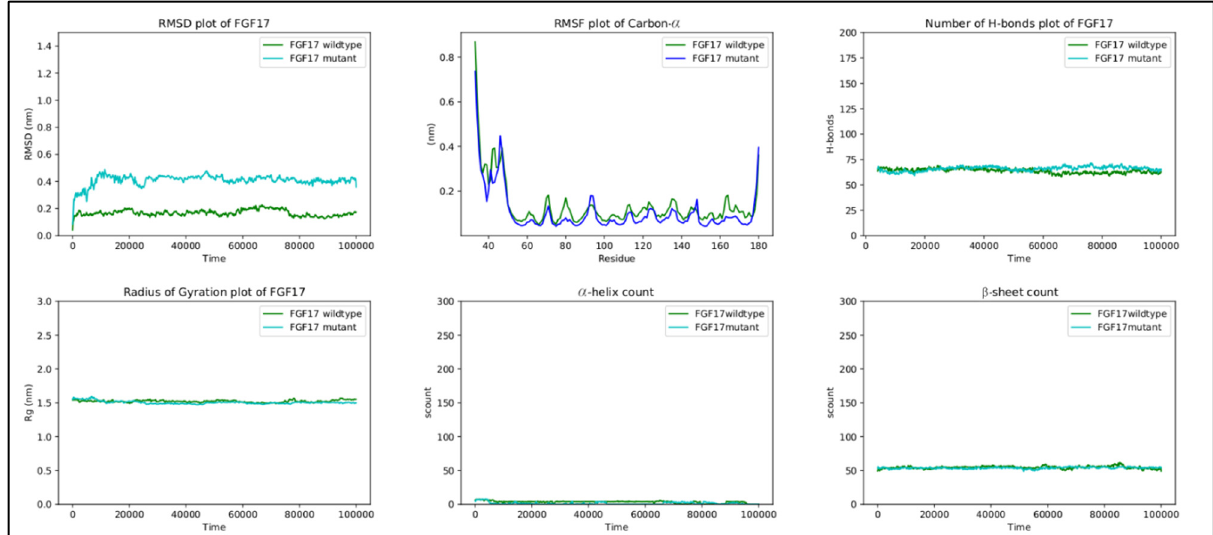
Figure 4. RMSD, RMSF, hydrogen bond count, radius of gyration, and secondary structure count plots of FGF17.